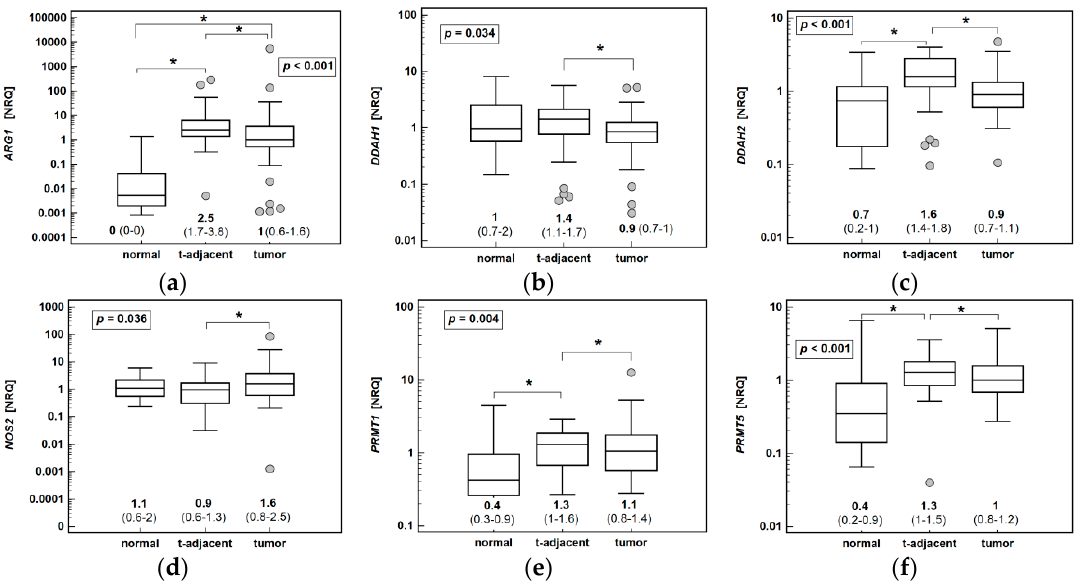
Figure 3. Comparison of arginine/nitric oxide pathway enzymes’ expression in normal colonic tissue and tumor and non-cancerous tumor-adjacent tissue: ( a ) ARG1 ; ( b ) DDAH1 ; ( c ) DDAH2 ; ( d ) NOS2 ; ( e ) PRMT1 ; ( f ) PRMT2 . Data analyzed using a Kruskal–Wallis H test. Numeric data present medians of normalized relative quantities (NRQ), accompanied by 95% confidence interval (CI). Boxes indicate median with interquartile range; whiskers—95% CI; grey dots - outlying observations. *, significant between-group di ff erences ( p < 0.05); ARG2 , arginase 2; DDAH , dimethylarginine dimethylaminohydrolase; NOS2 , inducible nitric oxide synthase; PRMT , protein